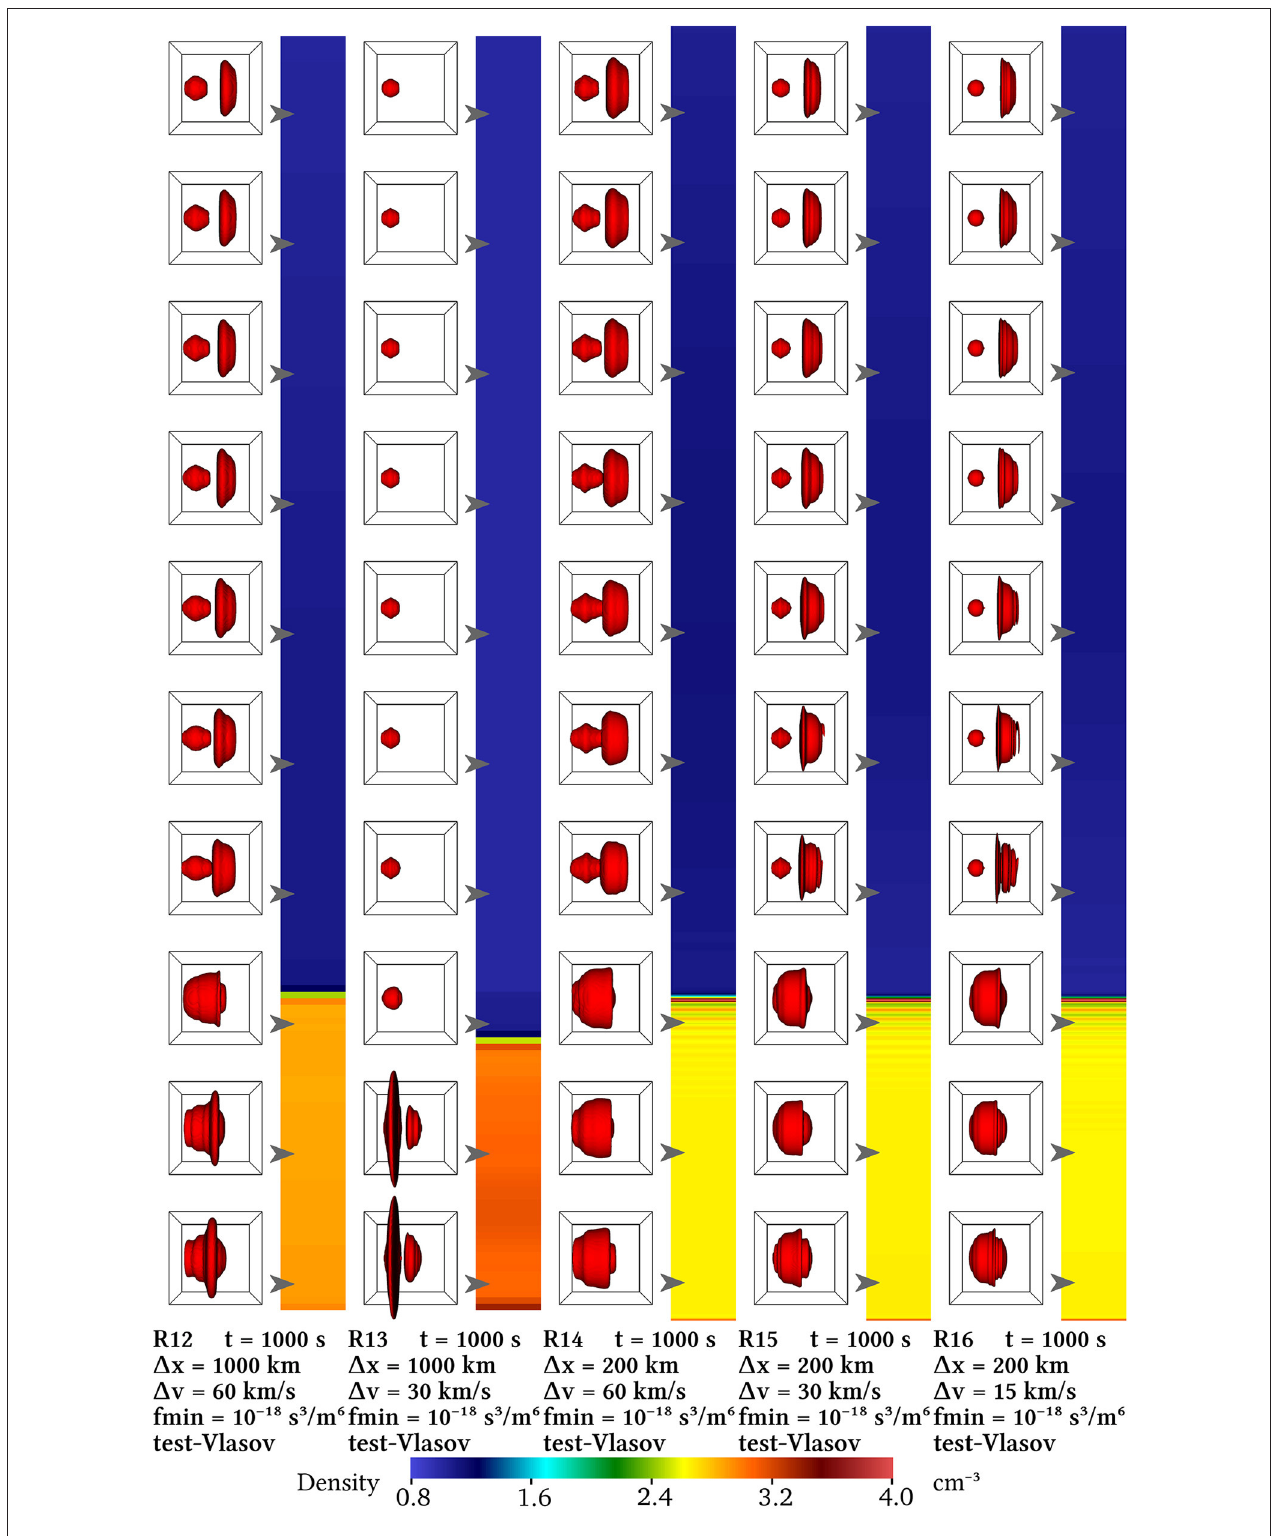
FIGURE 7 | Runs R12, R13, R14, R15, and R16 in the test-Vlasov (static fields) configuration. Although the results do converge at finer 1 x and 1 v (R15, R16), the coarser cases (R12, R13, R14) give clearly unphysical results. Animation A4 is the corresponding Supplemental data.